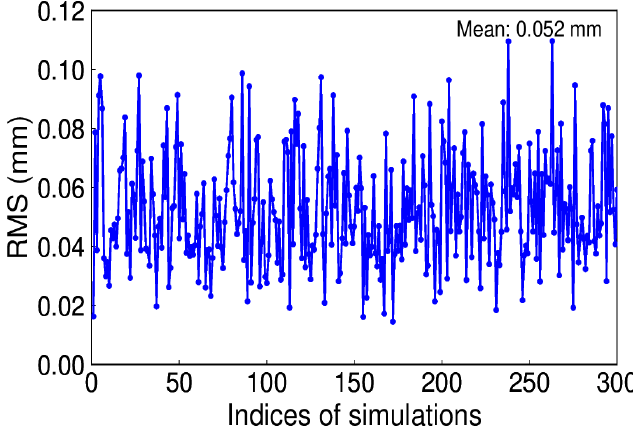
Figure 10. RMS of extracted and simulated signal with AR (3) noise.